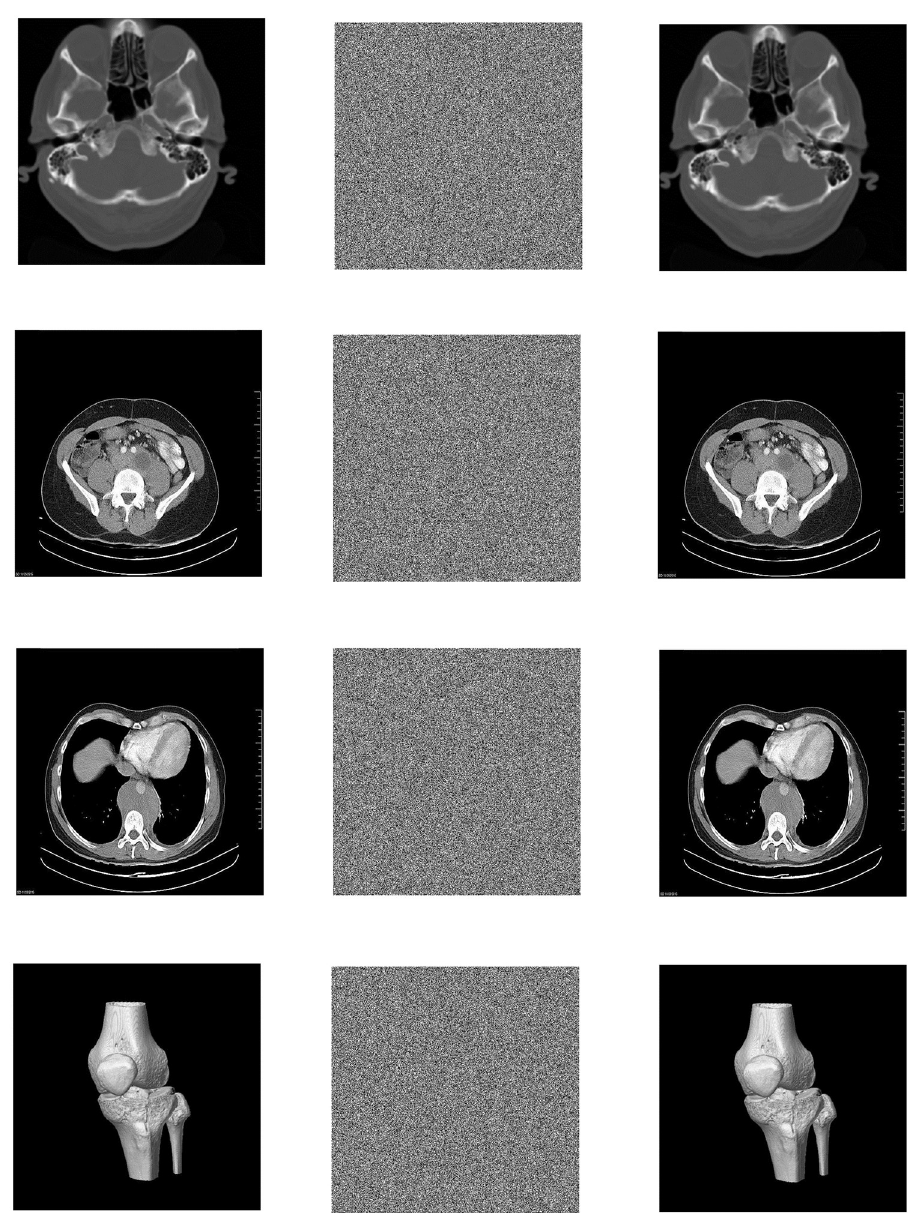
Fig 8. Simulation results of CT images. (a) Brain original image, (b) Brain encrypted image, (c) Brain decrypted image, (d) Old man testicular original image, (e) Old man testicular encrypted image, (f) Old man testicular decrypted image, (g) Testicular original image, (h) Testicular encrypted image, (i) Testicular decrypted image, (j) Tibial original image, (k) Tibial encrypted image, (l) Tibial decrypted image.